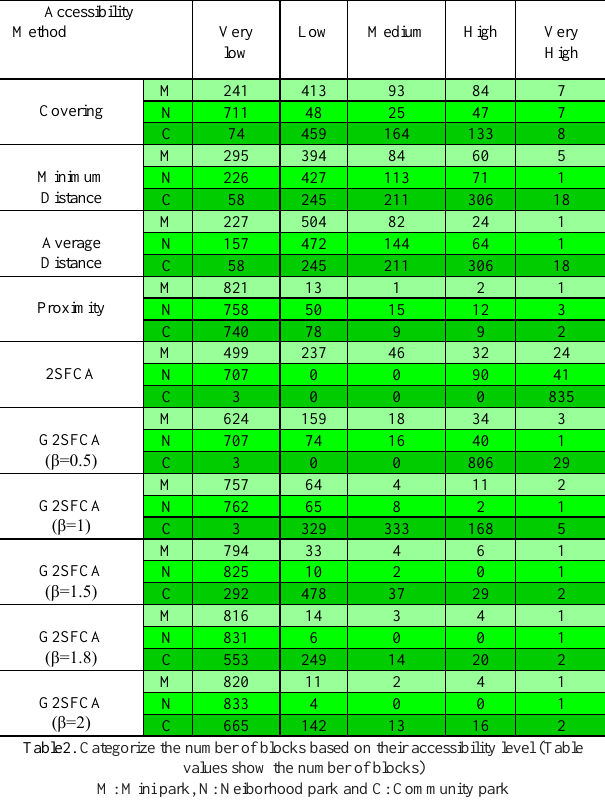
Table2. Categorize the number of blocks based on their accessibility level (Table values show the number of blocks) M: Mini park, N: Neiborhood park and C: Community